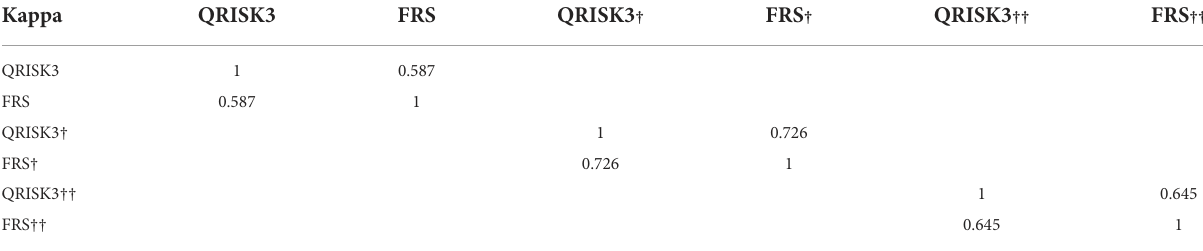
TABLE 4 Kappa coef fi cient demonstrating agreement among total risk category, low risk category and high risk category of QRISK3and FRS.